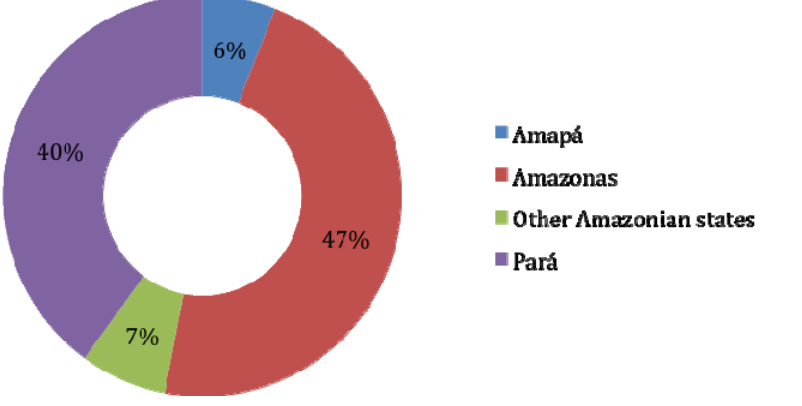
Figure 2. Protected areas and indigenous lands in Amazonian states (% of state